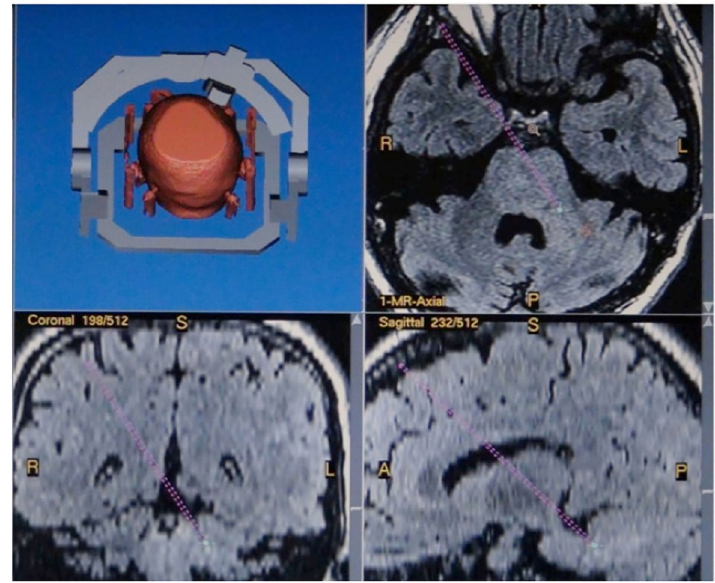
Figure 4. Case 4. Three-dimensional surgical plan: the extraventricular approach to suspicious biopsy targets on the left side of the brachium pontis.